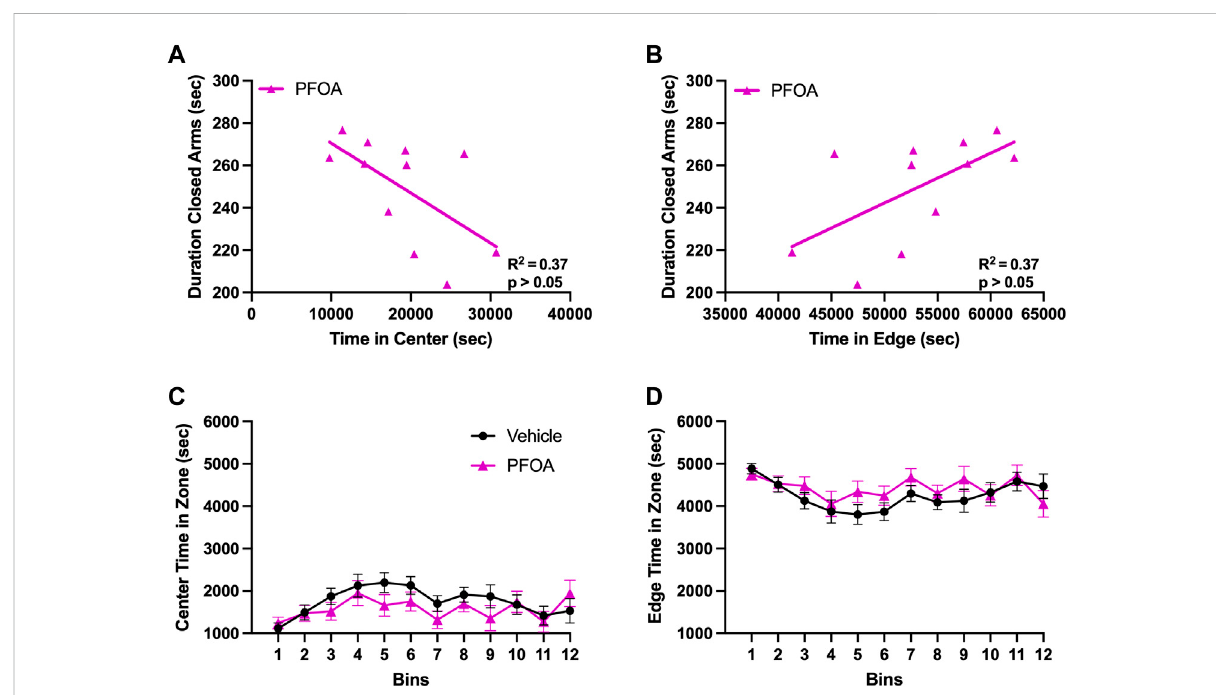
FIGURE 7 Closed Arm Duration in Relation to Locomotor Location. The total duration of time PFOA dams spent in the closed arms of the elevated plus maze was negative correlated with the duration of time spent in the center of the locomotor chamber (A) . Furthermore, the amount of time PFOA damsspentintheclosedarmsoftheelevatedplusmazewaspositivelycorrelatedwiththedurationoftimespentintheedgesofthelocomotorassay (B) .NodifferencewasobservedinthetimePFOAdamsspentineitherthecenter (C) ortheedge (D) ofthelocomotorchamber.GraphsCandD data shown as mean ± standard error of the mean, n = 11/PFOA and n = 13/vehicle. Data analyzed with either a Pearson correlation coef fi cient or repeated measures